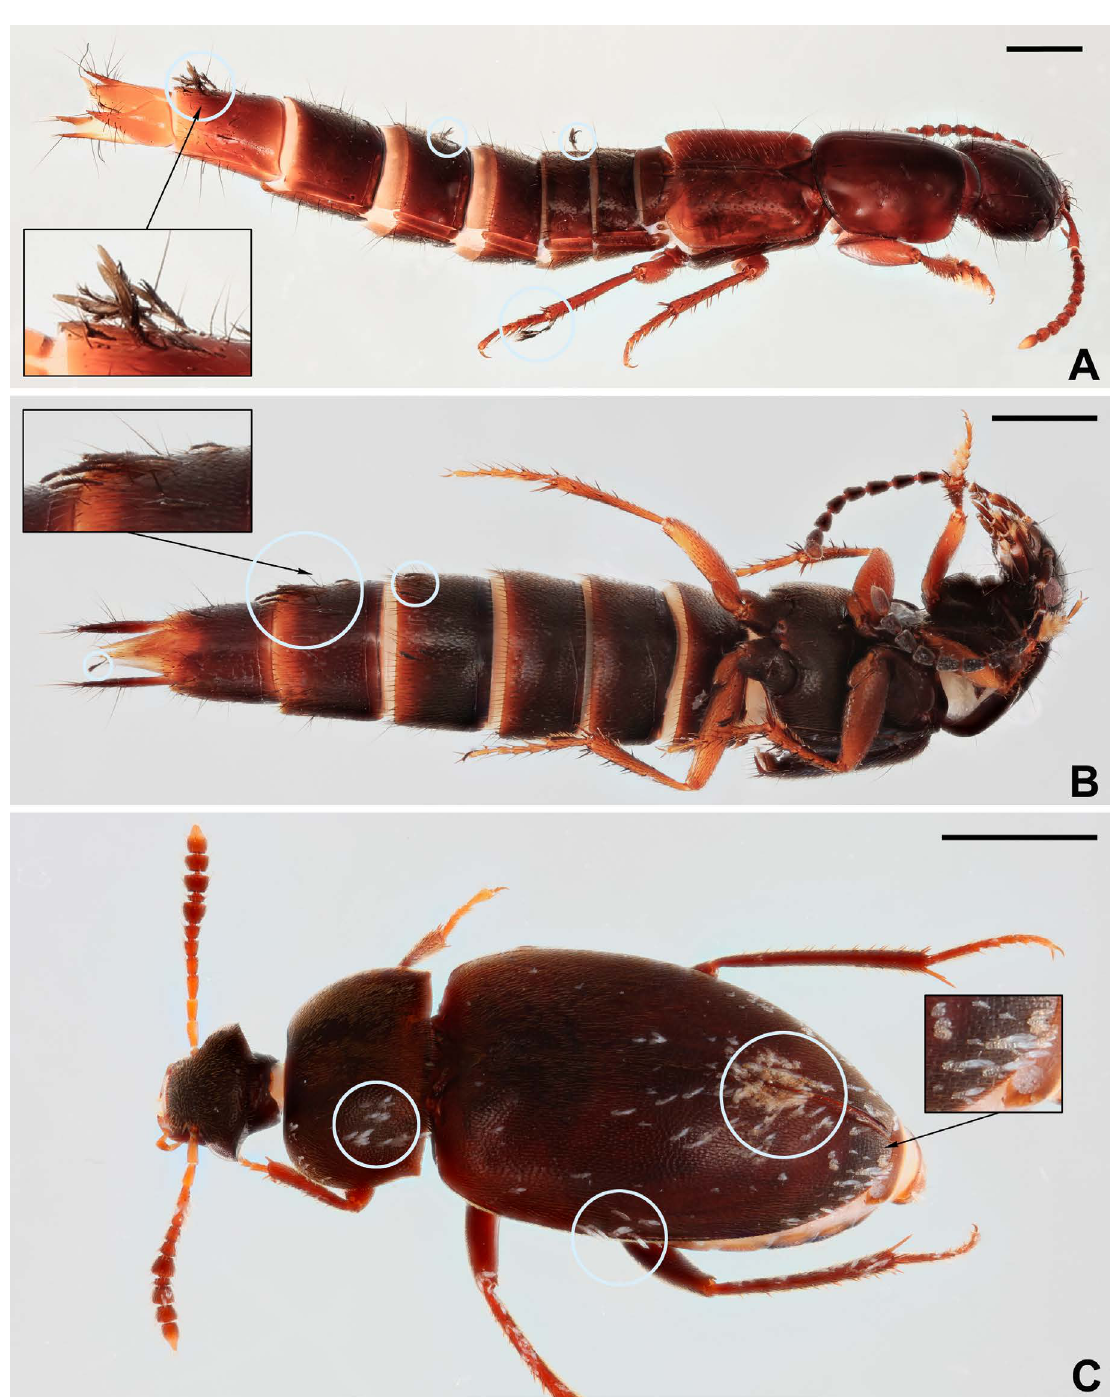
Fig. 102. Habitus of hosts with fungi. Some thalli are zoomed in, and others are encircled. A . Othius punctulatus with thalli of Rhachomyces furcatus . B . Philonthus fumarius with thalli of Rhachomyces philonthinus on the ventral side of the last 4 abdominal segments and a few on the left hind leg. C . Catops tristis heavily infested with Asaphomyces cholevae all over the body, even on the ventral side this specimen has just as many thalli. Scale bars: 1 mm. (Photos: Aslak Kappel